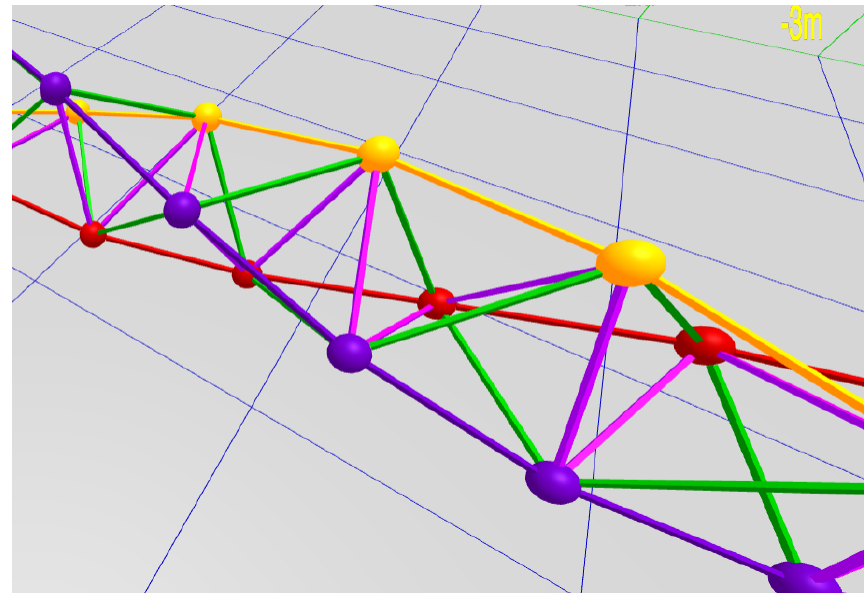
Figure 10. Boerdijk–Coxeter